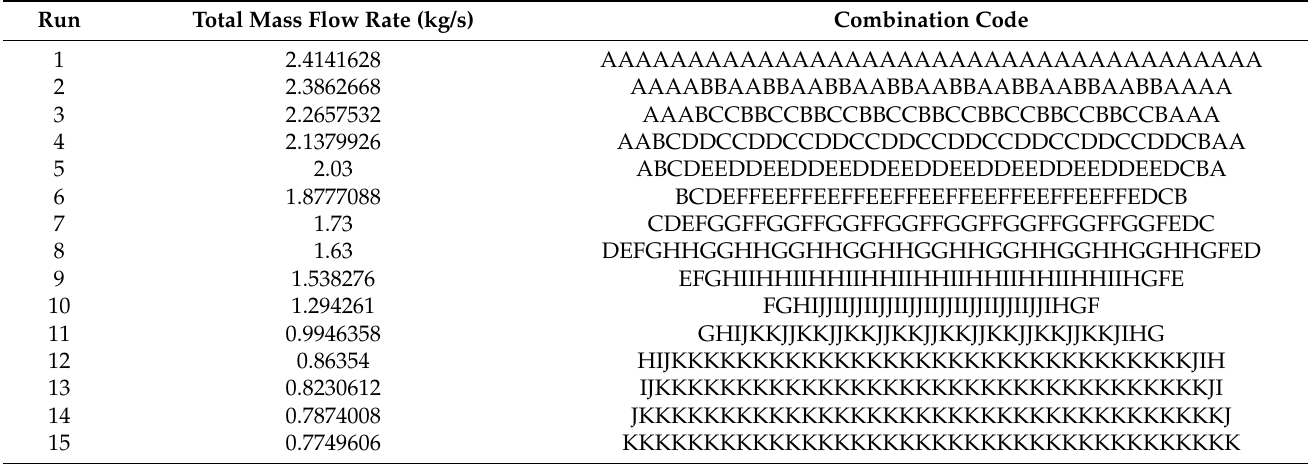
Table 9. Combinations of mass flow rates for eight stall